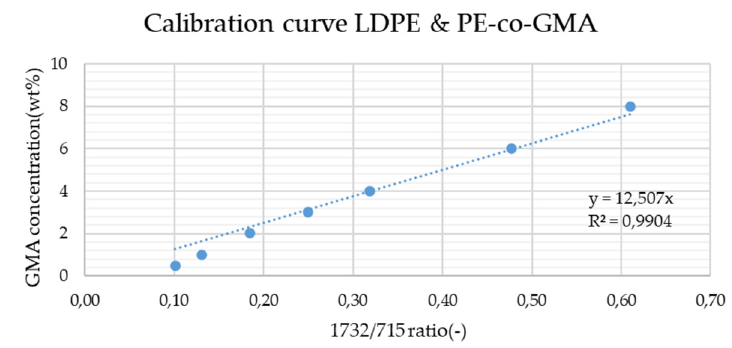
Figure A1. Calibration curve of LDPE and PE-g-GMA.